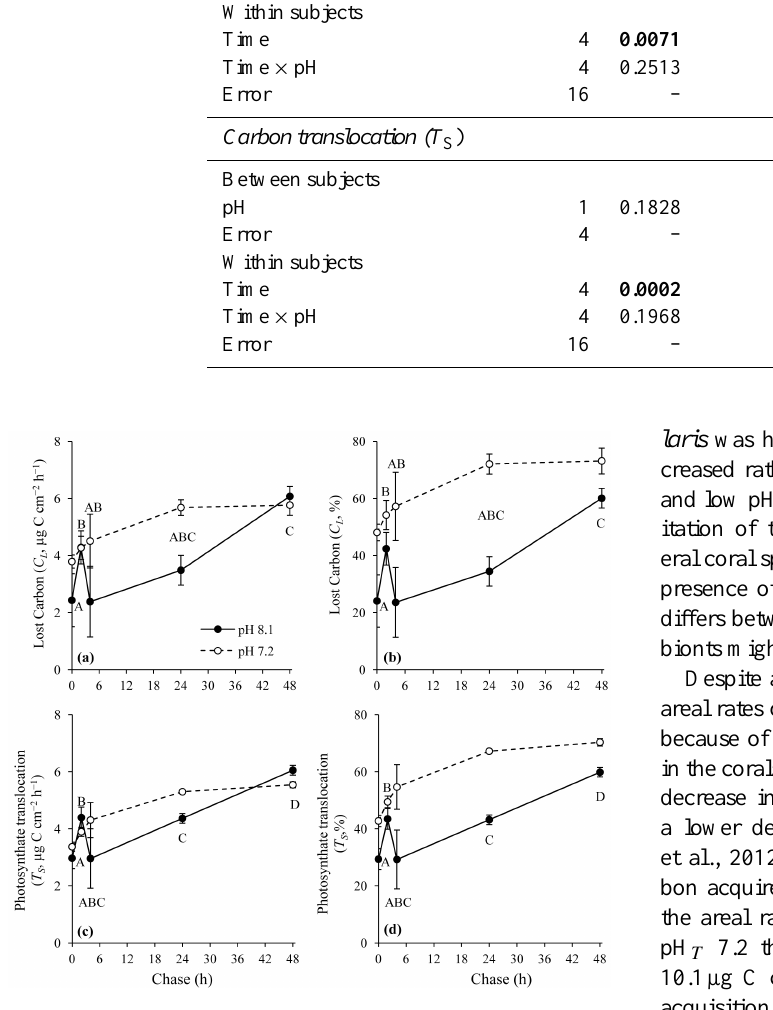
Fig. 4. (a) Amount and (b) percentage of carbon lost by symbiosis ( C L ) ; (c) amount and (d) percentage of photosynthesized carbon translocated to the host by symbionts ( T S ) for Stylophora pistillata at pH T 8.1 and 7.2. Data are means ± standard error of means of n = 3 measurements. Chase intervals with different letters (A to D) are significantly